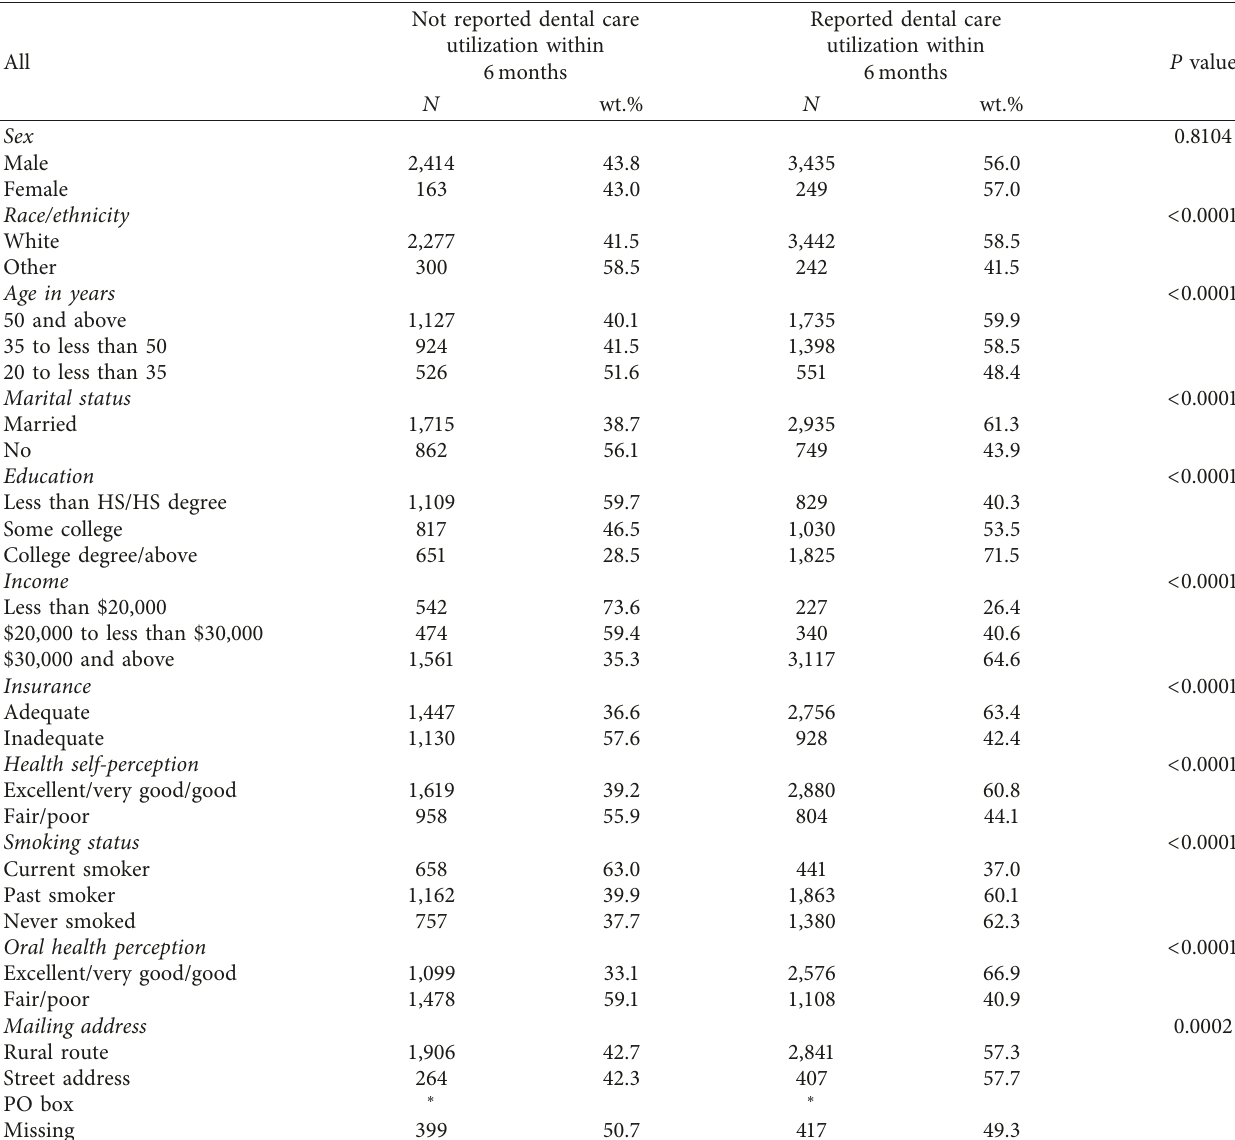
Table 2: Veteran reports of dental care utilization within the previous 6months by the National Survey of Veterans, 2010.